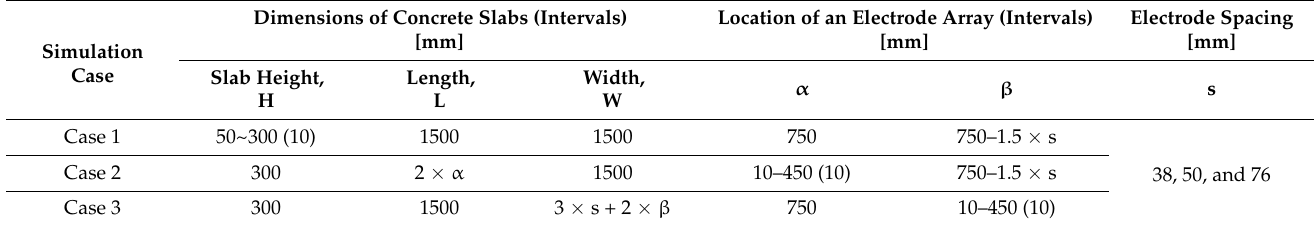
Table 1. Main variables of the numerical simulations in this study.